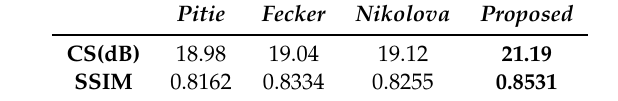
Table 2. Comparison for real image pairs (Average of 35 pairs).